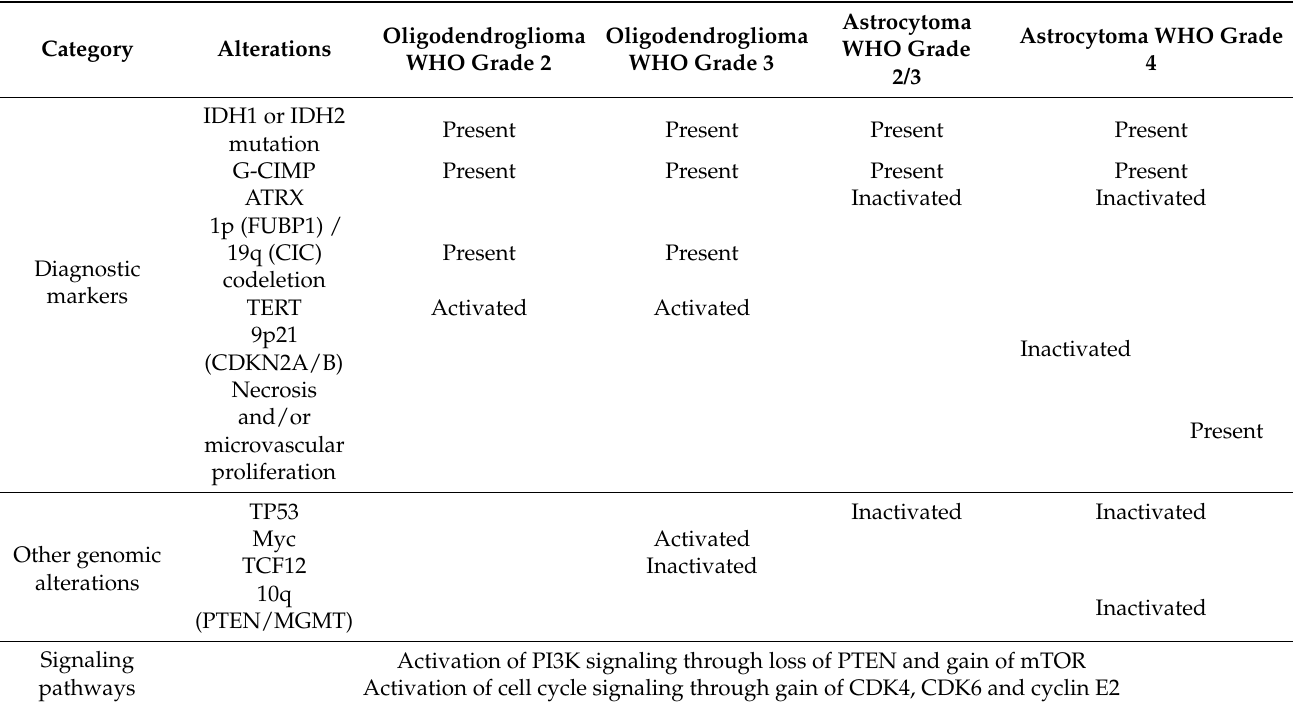
Table 1. Molecular diagnostic markers and common genetic alterations in IDH-mutant glioma.